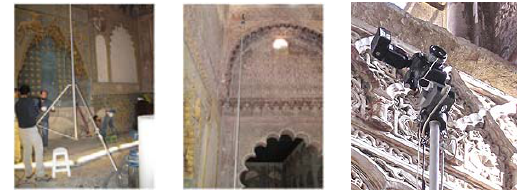
Figure 8. Telescopic mast used in the side wall photographs.